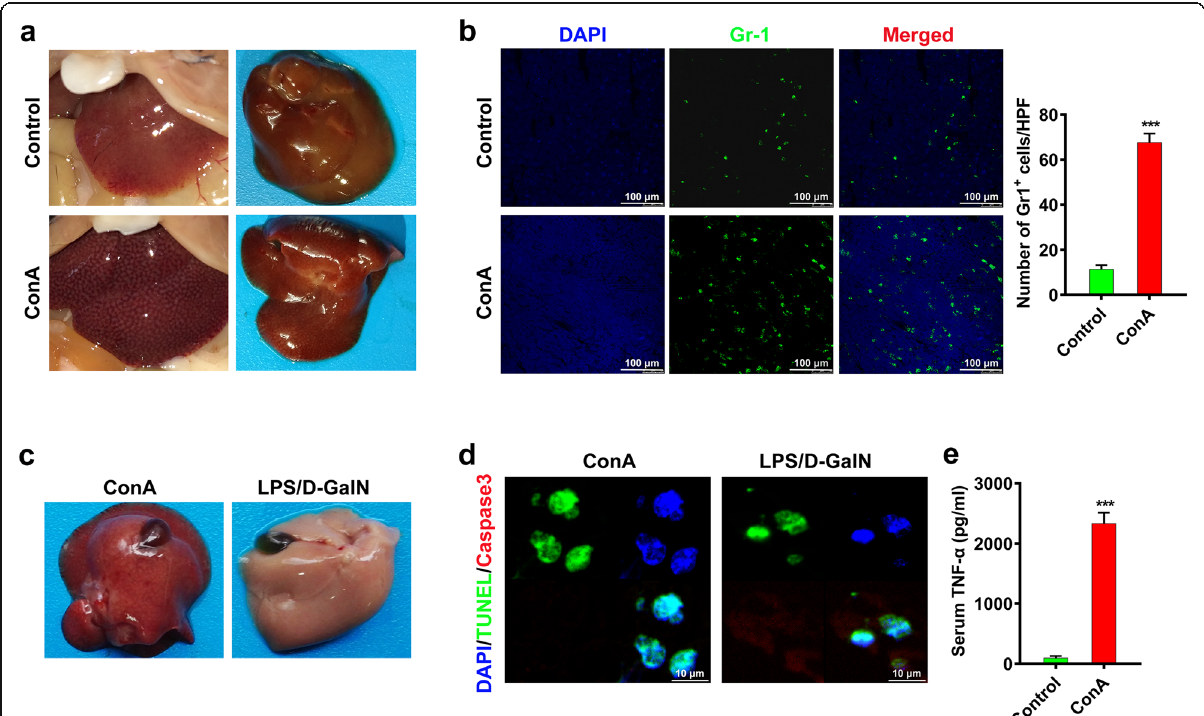
Fig. 1 ConA-induced acute live injury was featured by necrotic liver injury. a Acute liver damage was induced in WT C57BL/6 mice. After 10 h of ConA injection, the pathologic gross picture was presented. b The Gr-1 immunofluorescence staining result indicated a large amount of inflammatory cells infiltration in liver tissues induced by ConA. c Representative images of mice liver showed that ConA induced liver injury had different appearance from LPS/D-GalN induced liver injury. d The liver section of LPS/D-GalN model showed both TUNEL positive and cleaved caspase-3 positive, while the liver section of ConA model was primarily TUNEL positive. e The serum TNF- α level was significantly increased at 10 h after ConA injection. (***p < 0.001